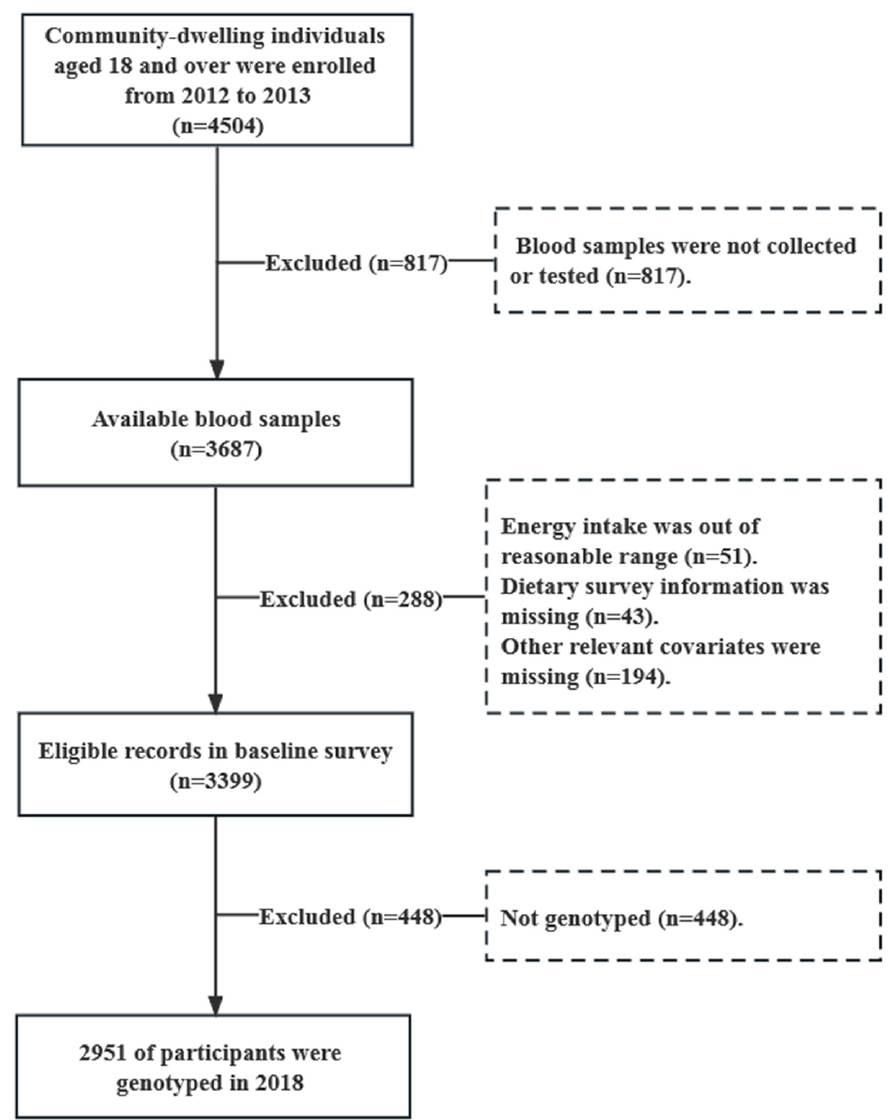
Figure 1. Flow chart of the study participants.